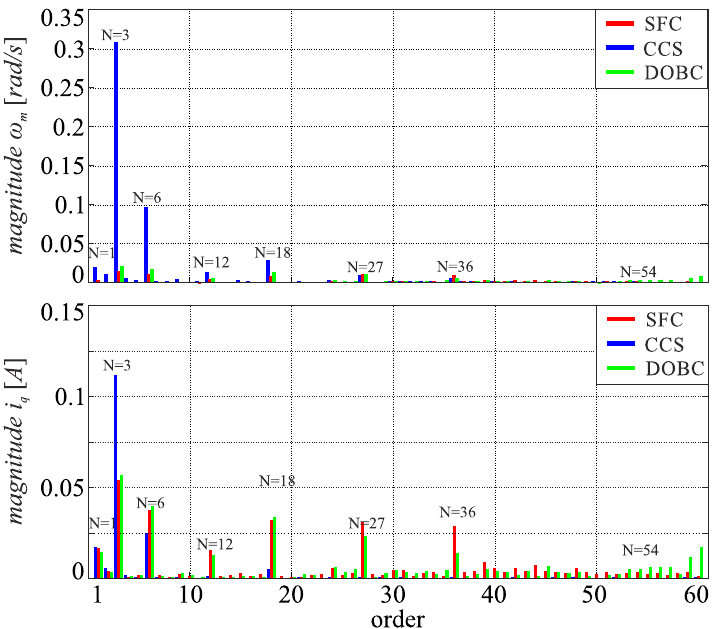
Figure 12. Frequency spectrum of angular velocity and quadrature current component for a set reference of 10 rad/s and constant load 3